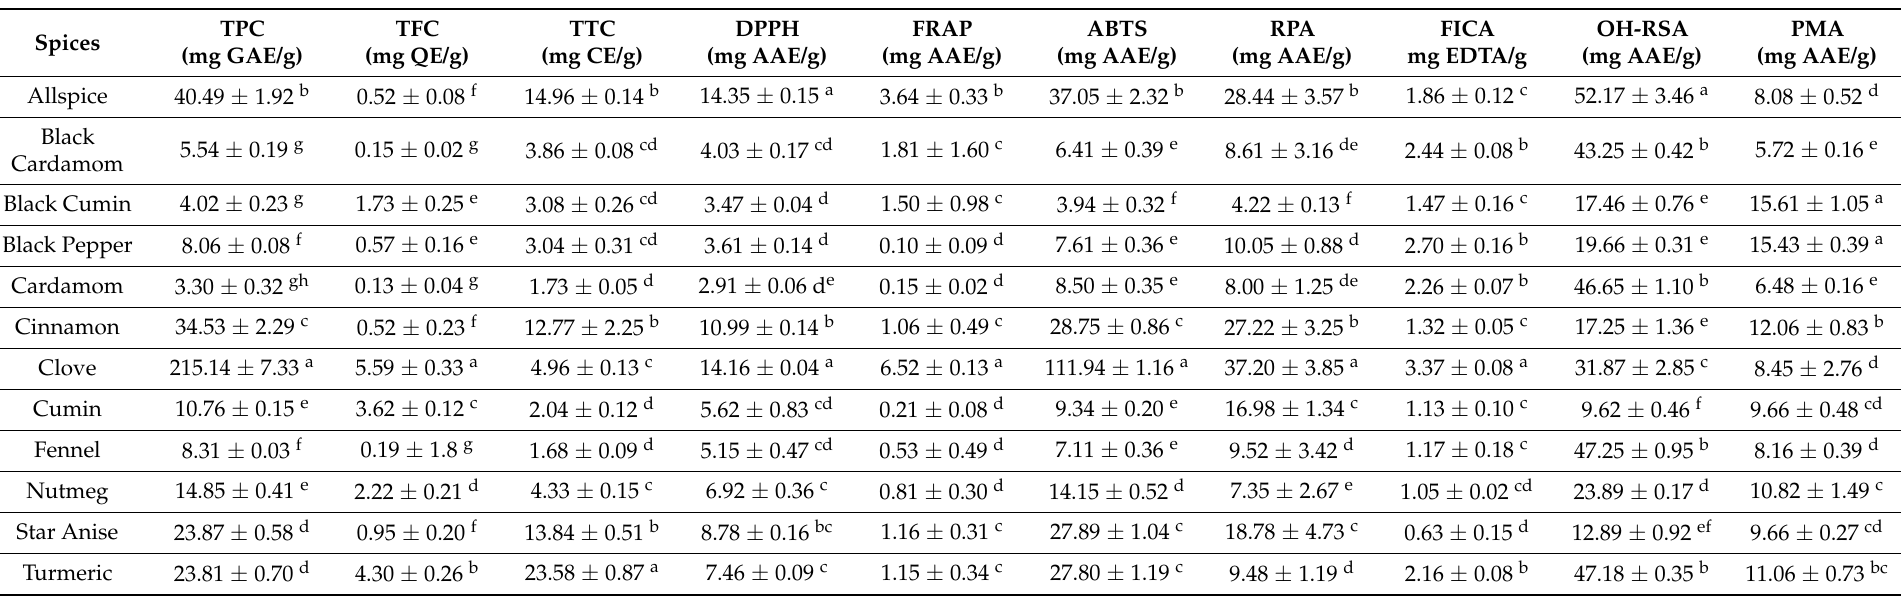
Table 1. Polyphenol contents and antioxidant activity of twelve